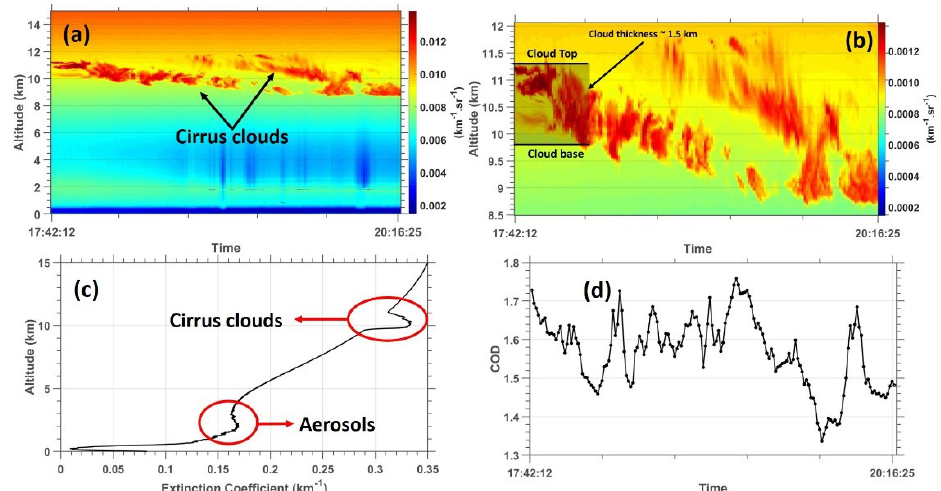
Figure 3. Height-time of total backscatter coefficients ( a , b ), extinction coefficient vs. altitude ( c ) and time evolution of cloud optical depth (COD) ( d ) for 10 April 2019.